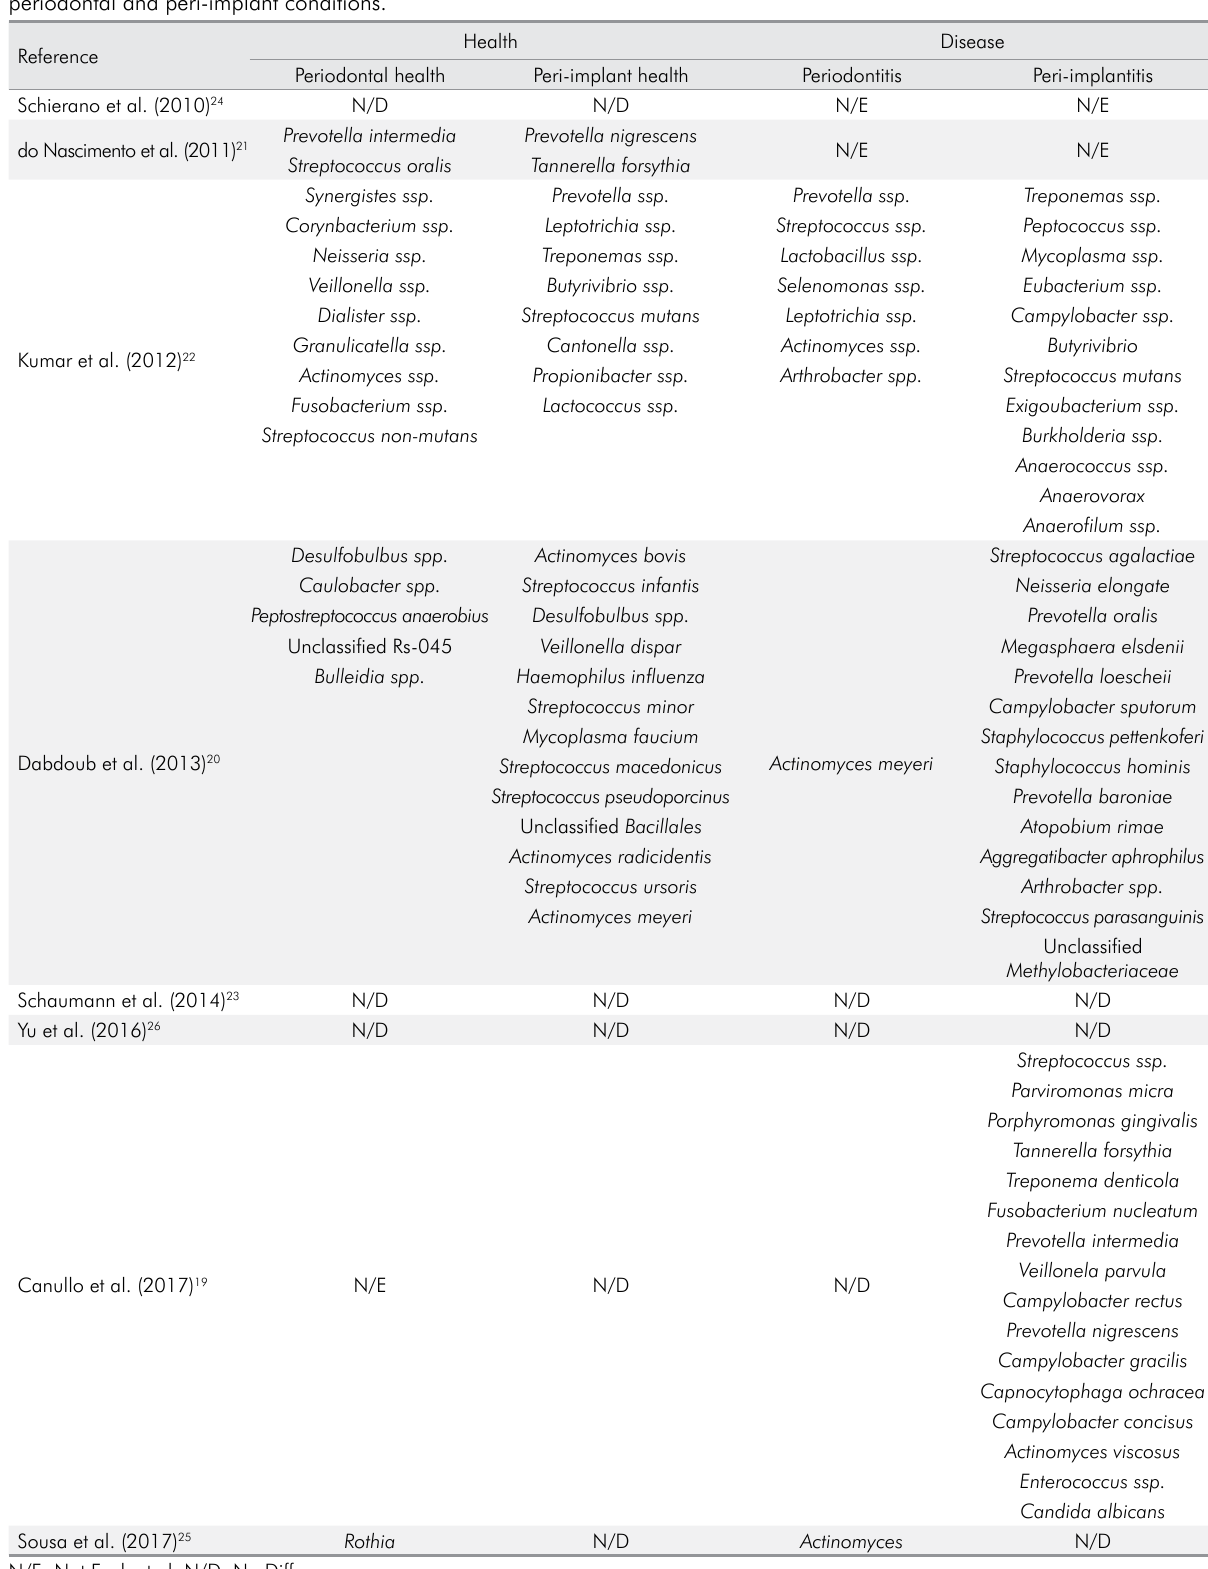
Table 6. Microorganisms found in statistically significantly higher counts/proportions/abundance/prevalence in the different periodontal and peri-implant